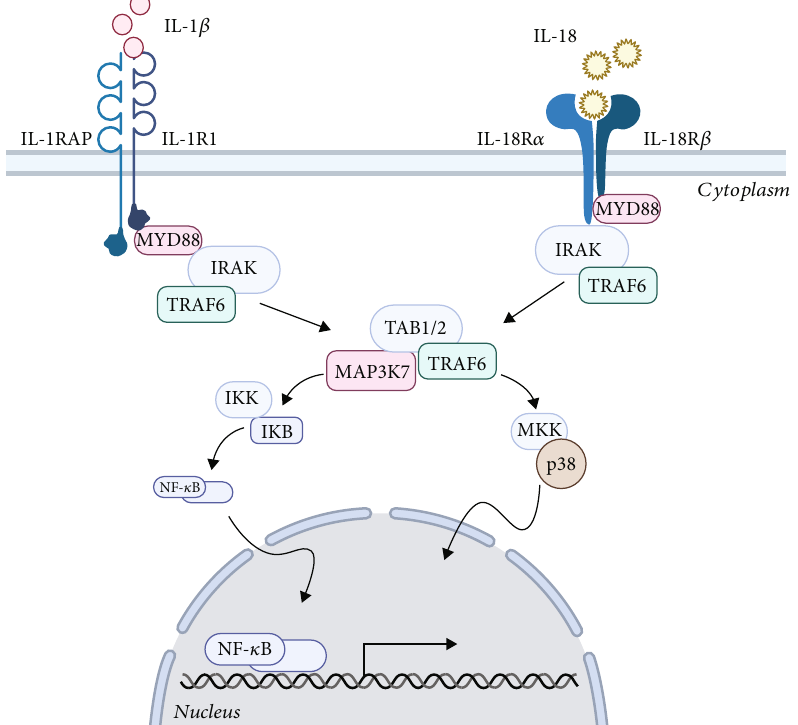
Figure 3: Signaling pathway of IL-1 β and IL-18. IL-1 β molecules are released in the cytosol and bind to IL-1R1 receptor in order to form a heterodimer with IL-1RAP. IL-1R is phosphorylated by MyD88 and IRAKs; thus, TRAF-6 are activated and able to further activate speci fi c MAP kinases and NF- κ B. Then, NF- κ B is translocated to the nucleus and initiates the transcription of proin fl ammatory molecules. Similar to IL-1 β , the IL-18 molecules follow a parallel pathway with the same outcome of production of proin fl ammatory molecules (image created in